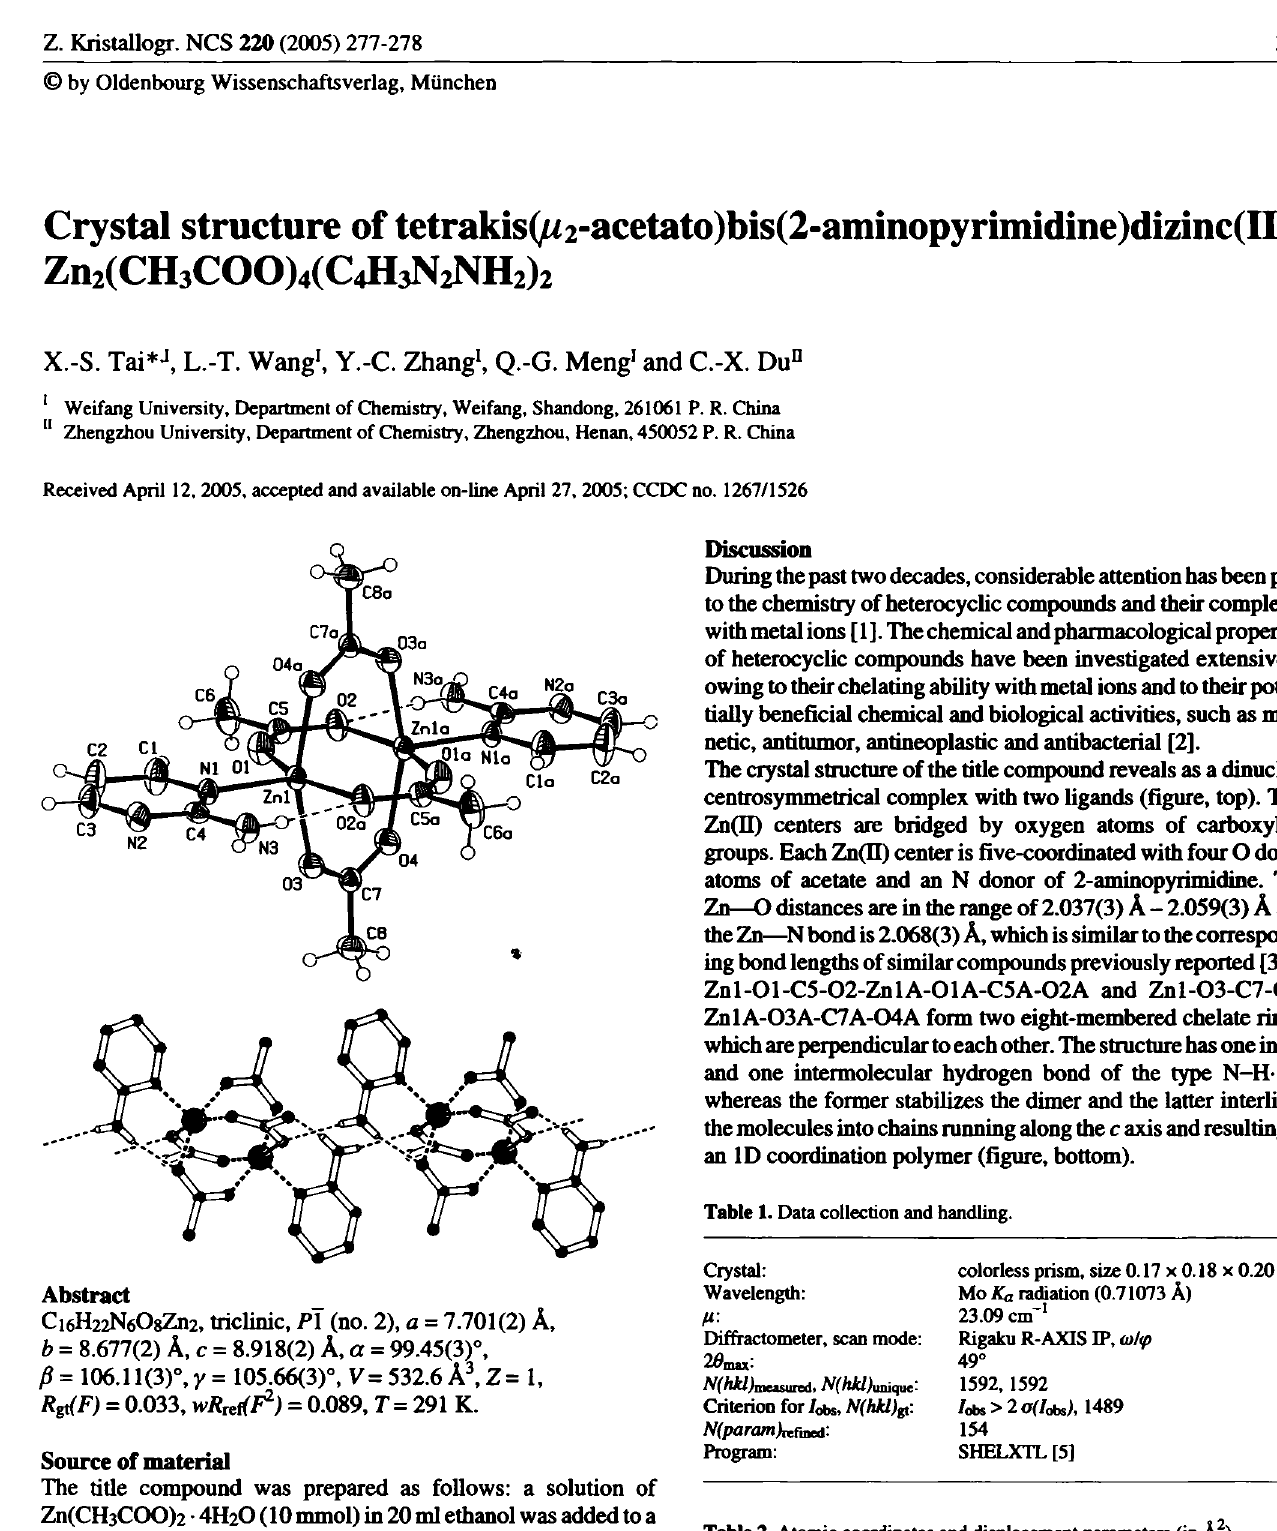
Table 2. Atomic coordinates and displacement parameters (in Ä 2